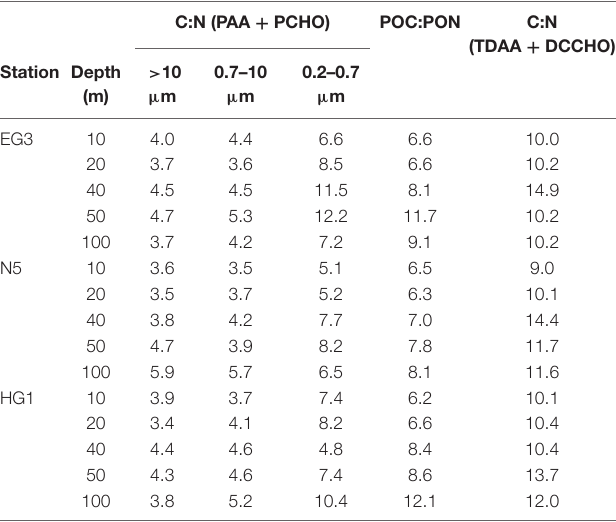
TABLE 3 | C:N ratios of biomolecules in different size fractions, and in DOM ( < 0.45 µ m) as well as POC:PON at stations EG3, N5 and HG1 for individual